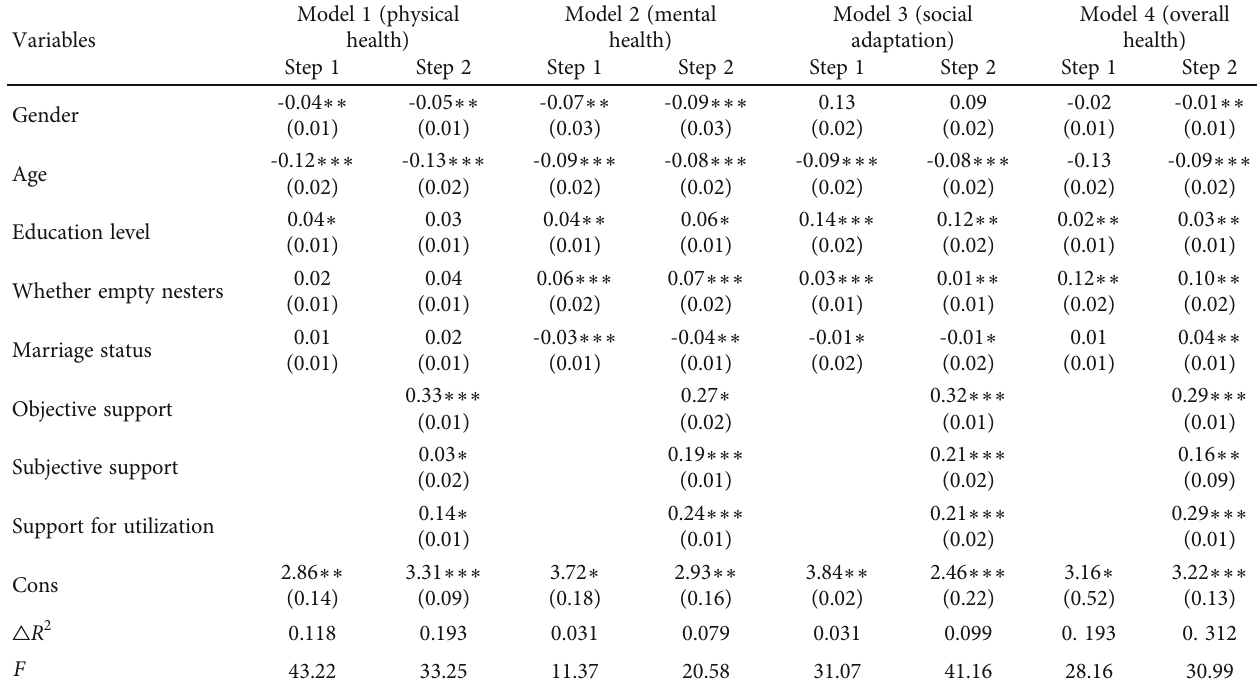
Table 3: E ff ect of social support on each dimension of health of the elderly in